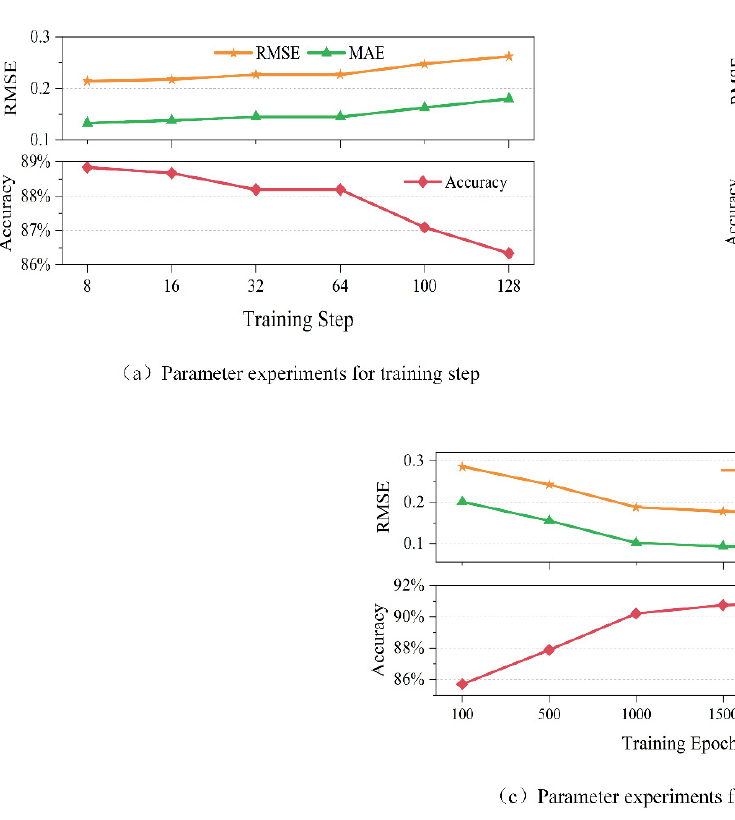
Figure 7. Parametric experimental results. ( a ). Effect of different training steps on STGCN performance with 100 GRU units and 500 model training epochs. ( b ). Effect of the different numbers of GRU units on STGCN performance with 500 training epochs and 16 training steps. ( c ). Effect of the different number of training epochs on STGCN performance with 100 GRU units and 16 training steps.